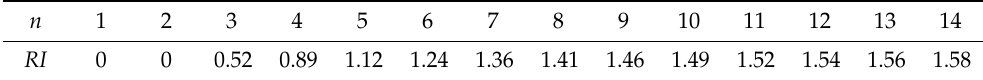
Table 2. Average random consensus